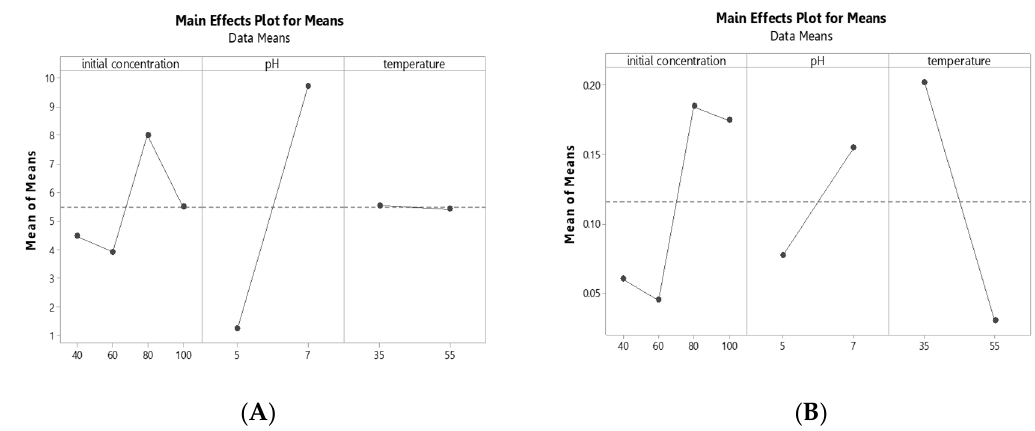
Figure 6. Response table from three factors of initial concentration of substrate, pH and temperature for means of: ( A ) hydrogen production; and ( B ) butyric acid production.